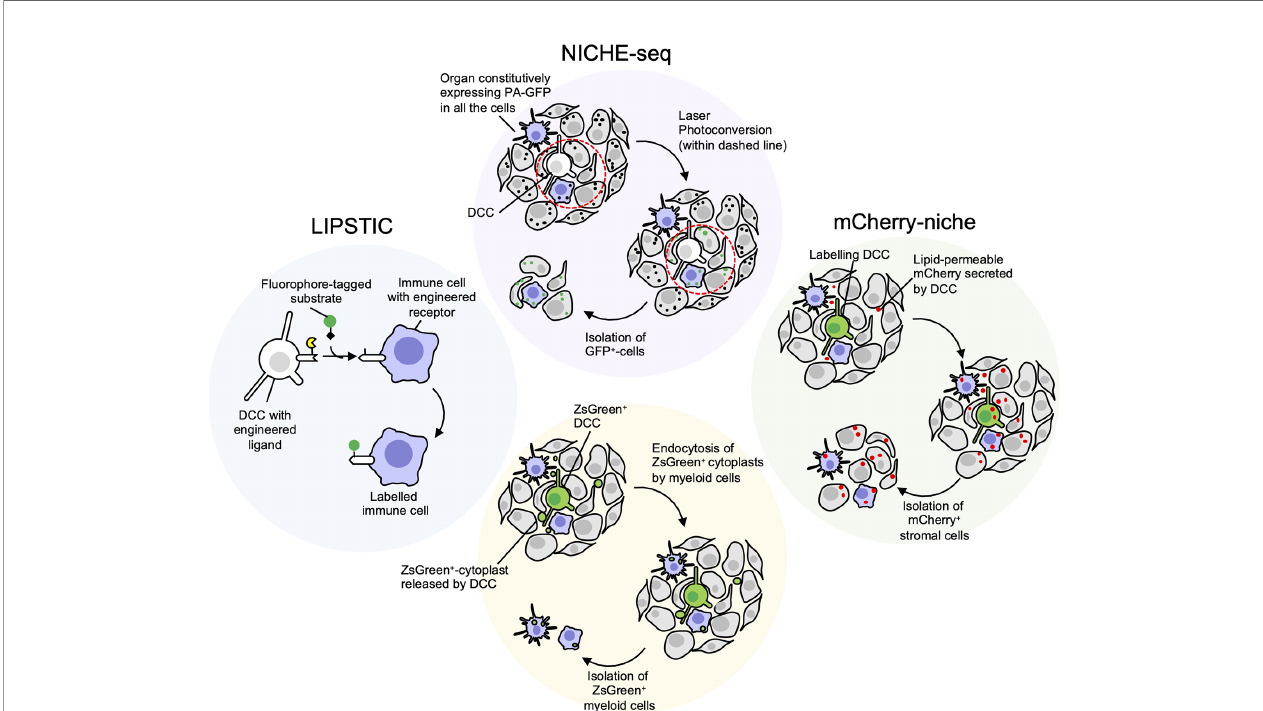
FIGURE 2 | Niche-labeling techniques for characterization of immune metastatic tumor microenvironment (TME). White/Green: cancer cells; Grey: stromal cells; Purple: immune stromal cells. NICHE-seq (172) employs transgenic mice constitutively expressing photoactivatable GFP (PA-GFP), a fl uorescent protein that increases its emission after excitation with 413 nm light (black dots: dark state; green dots: fl uorescent state after photoconversion). Once a disseminated cancer cell (DCC) is located in the metastatic organ the surrounding niche can be irradiated and GFP + cells isolated. Main limitations: i) the dif fi culties to spatially locate few scattered dormant DCCs (DDCCs) throughout entire organs; ii) the accessibility of those organs for photoconversion in vivo . The latter issue can be overcome with ex vivo photoconversion offreshly explanted organs. LIPSTIC (labeling Immune Partnerships by SorTagging Intercellular Contacts) (173) is an intercellular enzymatic labeling technique that exploits Staphylococcus aureus transpeptidase sortase A (SrtA, in yellow). Here, SrtA transfers a substrate containing “ LPXTG ” motif (black diamond), fused with biotin or fl uorophore, to fi ve N-terminal glycine residues tag (G5). This transfer requires proximity of SrtA and G5, thus a receptor and its membrane-bound ligand are fused with either SrtA and G5 in different cells. If these cells, that could be DDCCs and stromal cells, lie in close proximity at the metastatic site, stromal cells surrounding DDCCs are labeled and can be isolated for further analysis. Main limitations: i) the stromal lineage of interest must be genetically engineered a priori with tagged receptor or ligand, making this technique not suitable for unbiased identi fi cation of niche stromal cells; ii) the cells must be in close proximity for the reaction to happen. Cherry-niche (172) was developed to overcome these limitations. Here, the mCherry protein is engineered with a lipid-permeable domain (sLP-mCherry). DCCs expressing the sLP-mCherry release the protein in the extracellular space and the protein is uptaken by neighboring cells that can be isolated and analysed. Similarly, Krummel lab observed that blebs (cytoplasts, green dots) released by disseminated ZsGreen + - melanoma cells are endocytosed by resident myeloid cells (159). This approach is limited to DCCs releasing a signi fi cant amount of blebs and to stromal cells with ef fi cient endocytic